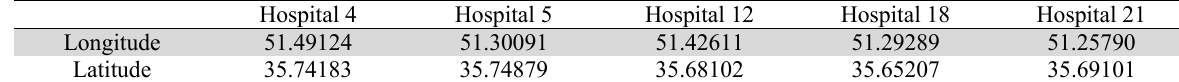
Geographic coordination of